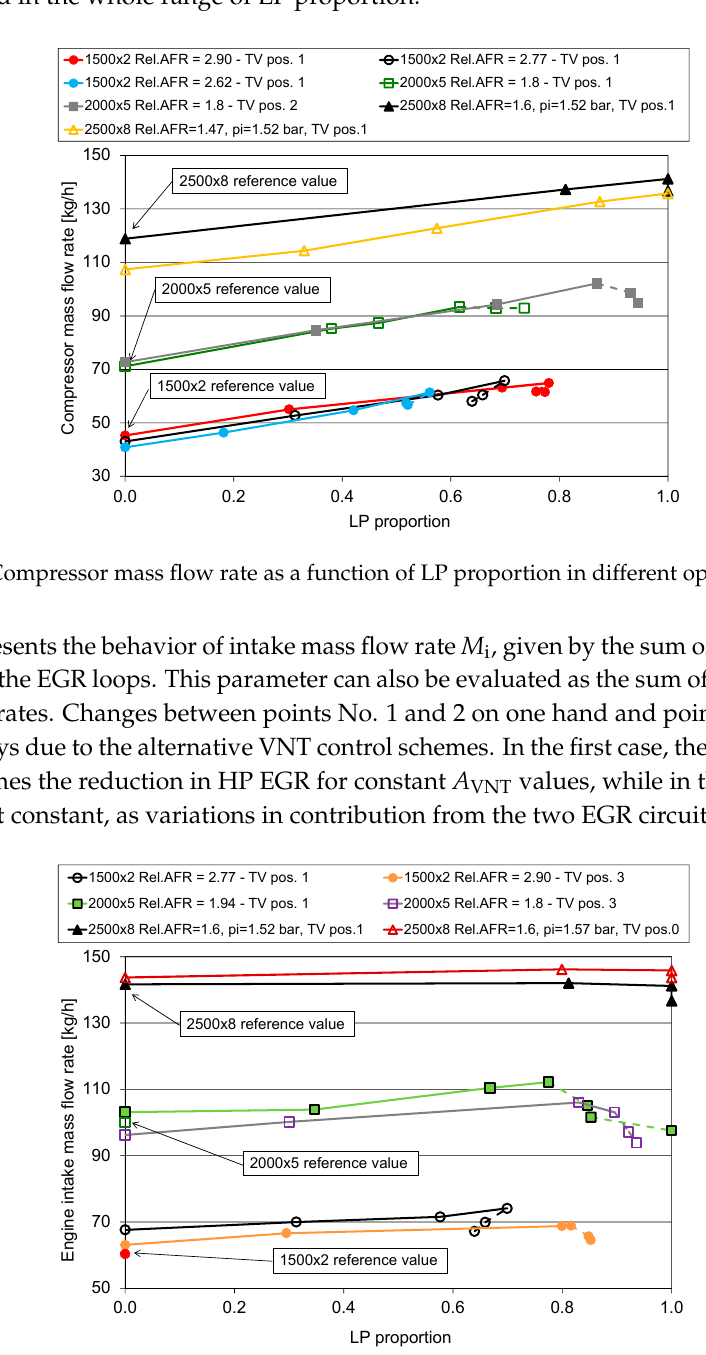
Figure 3. Engine intake mass flow rate as a function of LP proportion in different operating modes.